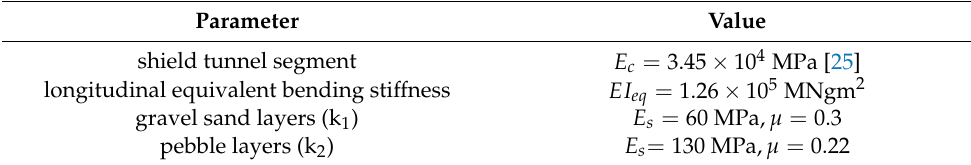
Figure 7. Sectional view of interchange passages and Metro Line 10. Table 1. Model input parameters for case